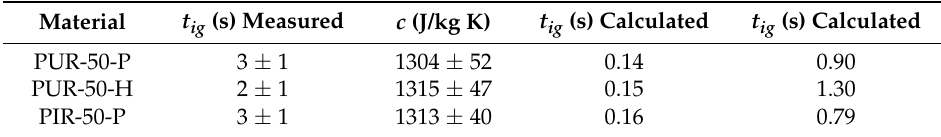
Table 4. Specific heat capacity as well as calculated, measured, and corrected t ig for foams with a density of 50 kg/m 3 .